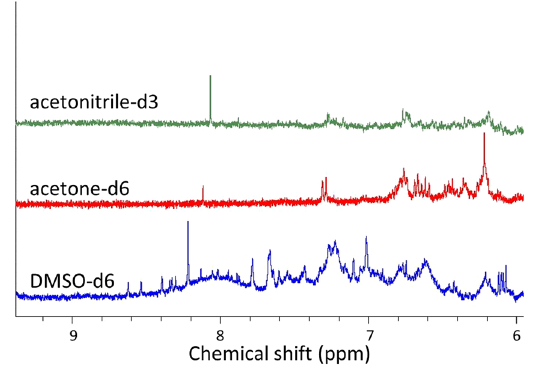
Figure 1. 1 H solution NMR spectra of paprika powder extracted by DMSO-d6 (bottom), acetone-d6 (middle), and acetonitrile-d3 (top).